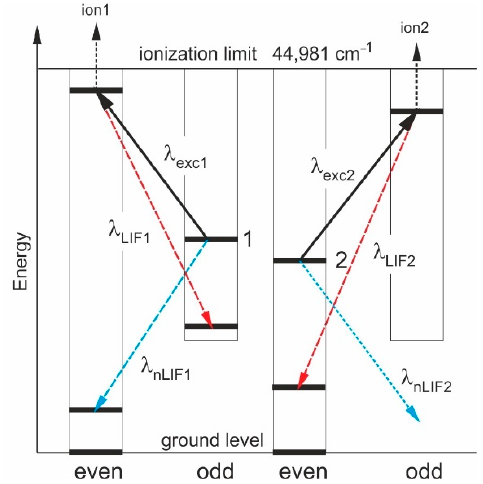
Figure 2. Schematically excitation scheme of La I. See text for description.